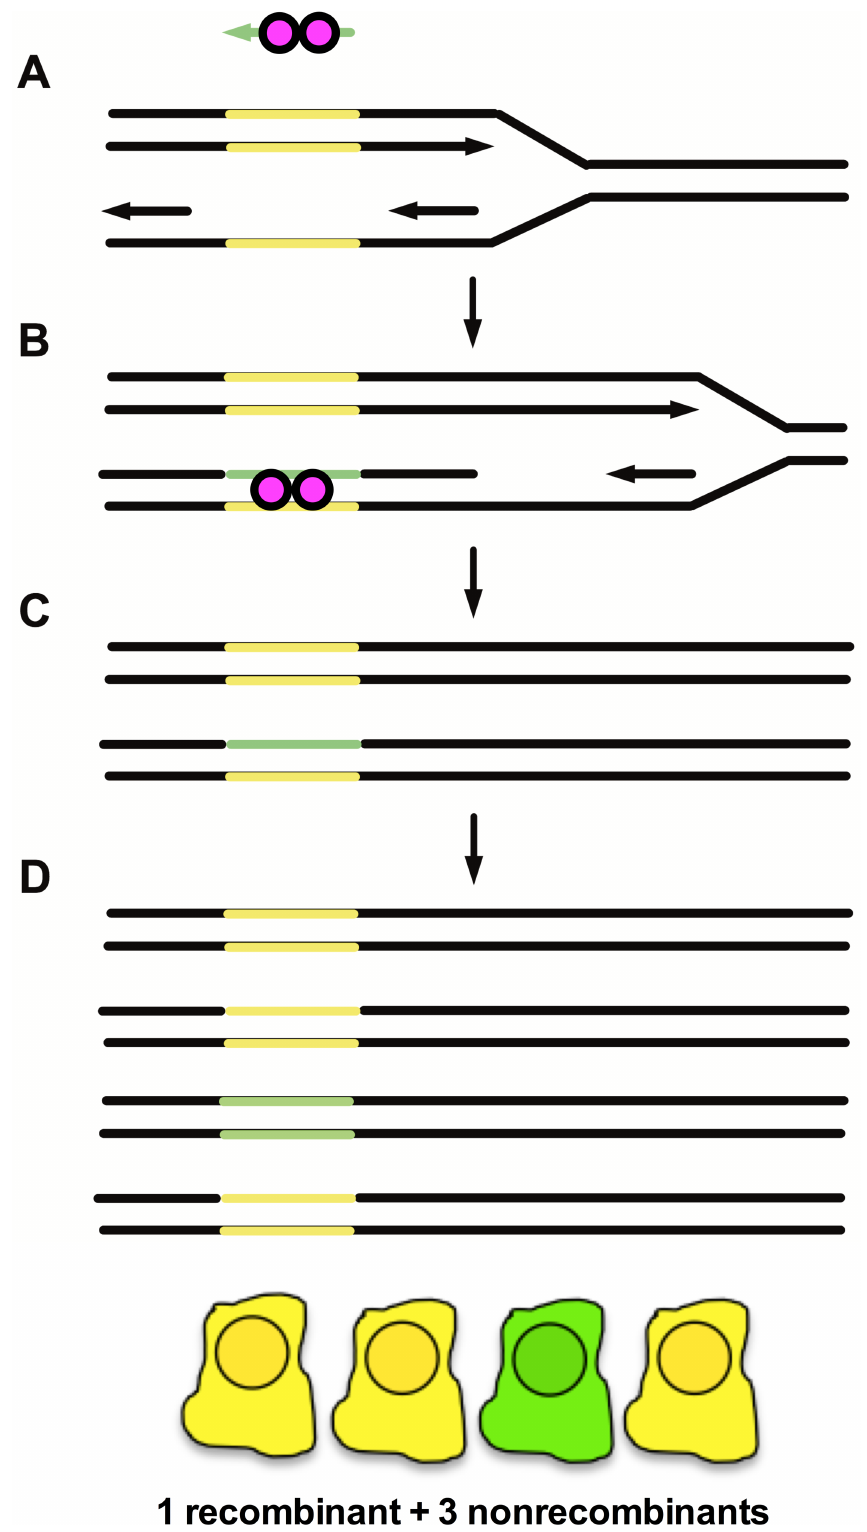
Fig 1. ssDNA (oligo) recombineering model. A) Synaptases (pink balls) bind to ssDNA (represented by the green left-facing arrow at top) to form a nucleoprotein filament. B) The nucleoprotein filament samples ssDNA sequences